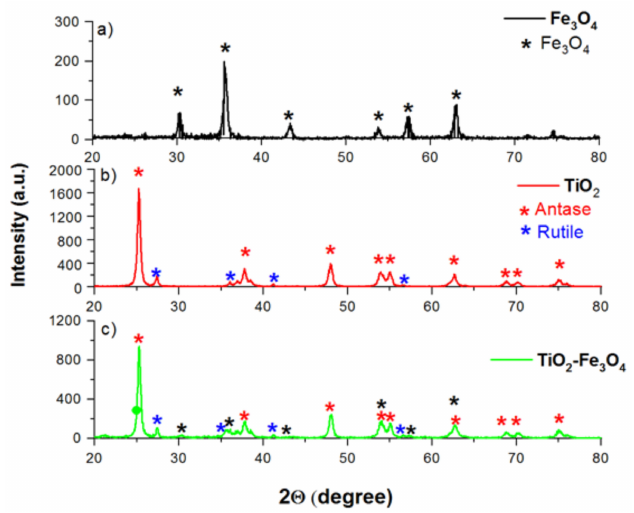
Figure 3. XRD patterns of ( a ) Fe 3 O 4 , ( b ) TiO 2 and ( c ) TiO 2 –Fe 3 O 4